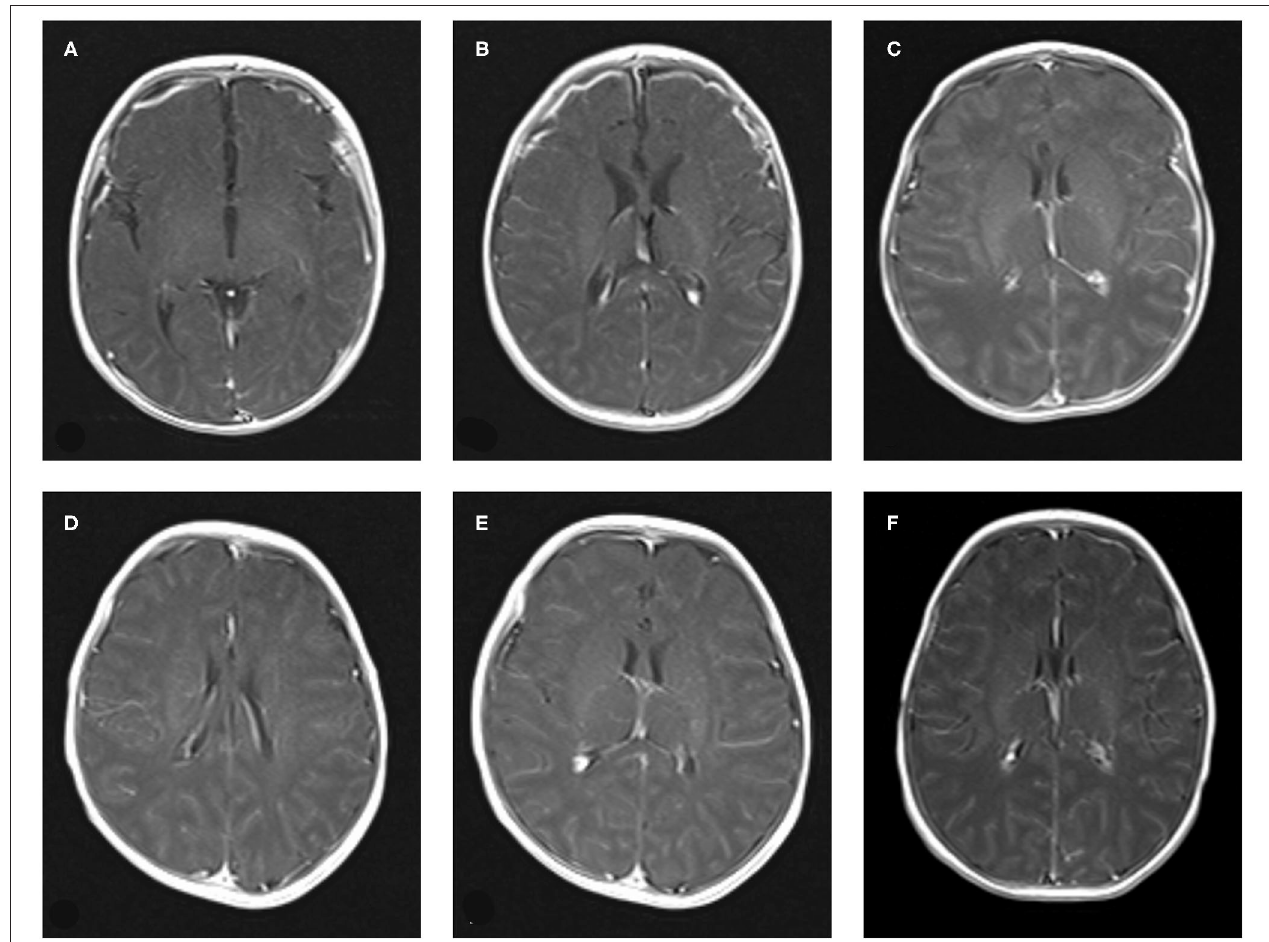
FIGURE 1 | The manifestation of craniocerebral MRI enhanced scan of Neonatal HFMD complicated with encephalitis. (A–C) : Bilateral meningeal enhancement. (D–F) : The vascular shadow on the surface of the brain increased slightly.